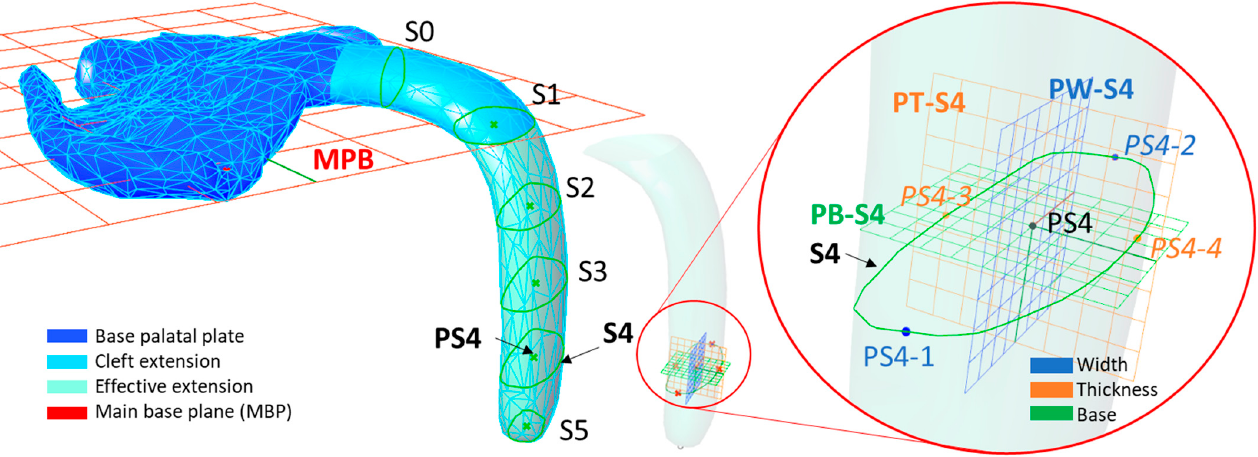
Table 1. Resume of recorded values and their respective acronyms. Example for Section 4 (S 4 ).